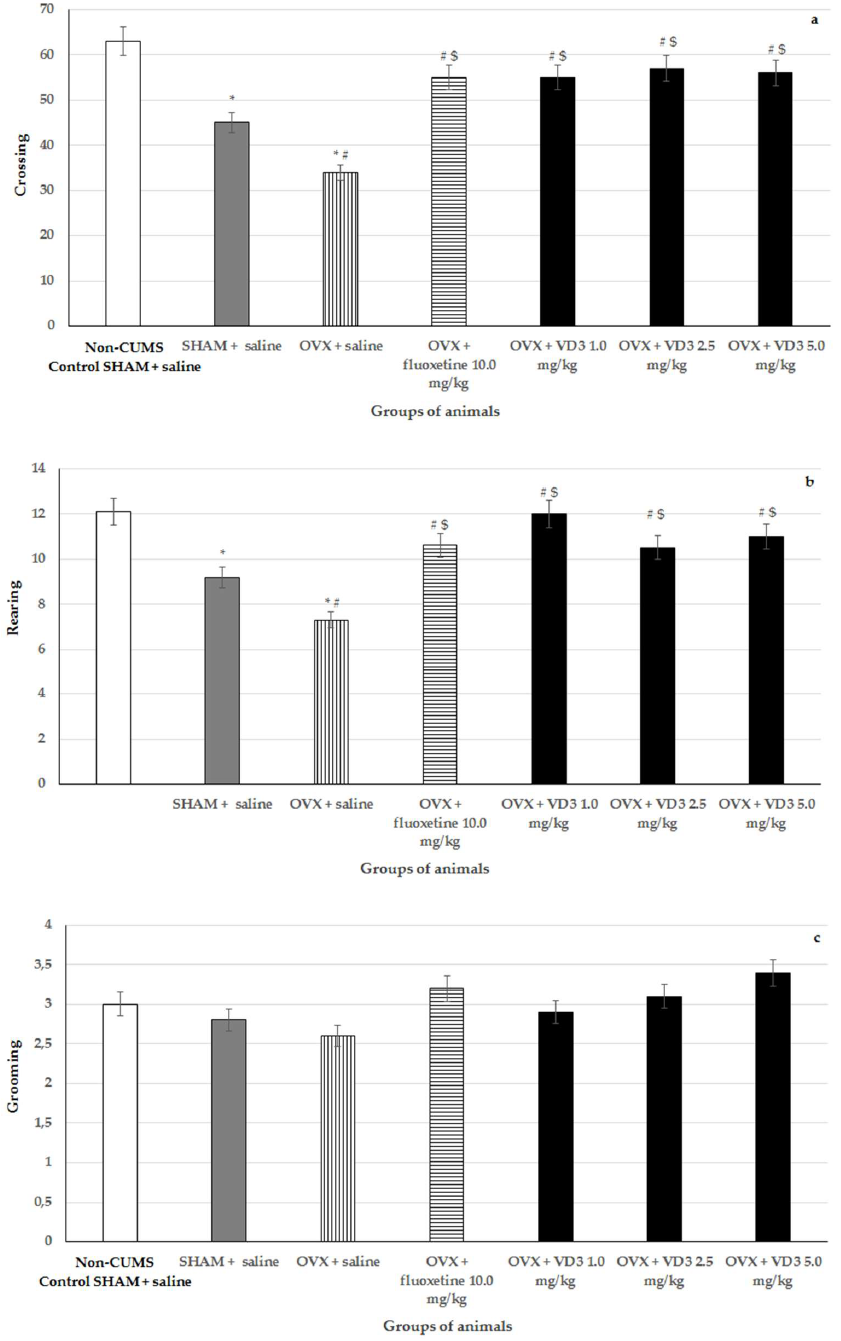
Figure 5. E ff ects of VD 3 administered in various doses on the behavior in long-term OVX rats subjected to CUMS in the open field test. ( a )—crossing, ( b )—rearing, ( c )—grooming. *— p < 0.05 versus the non-CUMS SHAM group (control group) treated with saline, #— p < 0.05 versus the SHAM group with CUMS treated with saline, $— p < 0.05 versus the long-term OVX group with CUMS treated with saline. The data are presented as the mean ± SD; n = 7 in each